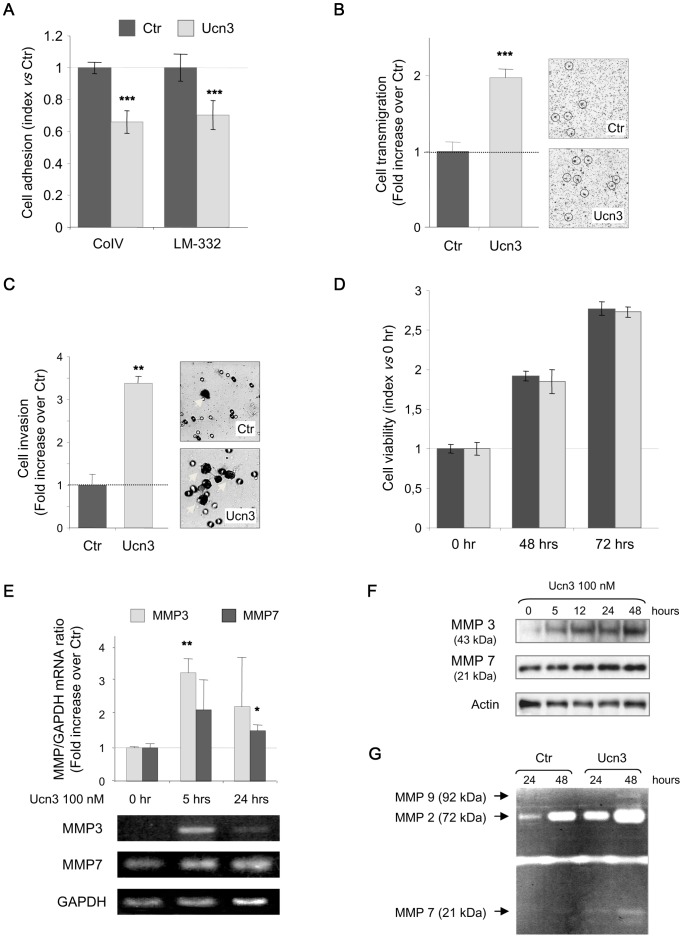
CRF2 signaling alters cell adhesion in favor to cell migration and invasion.(A) HT-29 were treated or not with Ucn3 (100 nM) 30 min before adhesion and then plated on either COIV or LN-332. Cell-ECM adhesion was evaluated at 60 min with the use of a Cell Titer Aqueous MTT reagent kit. Values are normalized to the adhesion without Ucn3. Data represent the mean +/− SEN of 4 separate experiments. Effect of Ucn3 on HT-29 cells transmigration after 72 hrs was determined using a transwell assay (B) and on HT-29 cell invasion after 48 hrs by a matrigel assay (C). In both assays cells were visualized by phase contrast microscopy and counted. A phase contrast image has been joined. A circle has indicated some migrating cells and some invaded cells have been indicated by a white arrow. Data (n>3) are given as mean +/− SEM. (D) Effects of Ucn3 on HT-29 cell viability. (E) Regulation of MMP3 and MMP7 mRNA expression analyzed by RT-PCR in HT-29 cells treated with Ucn3 100 nM. (F) Immunoblot analysis of MMP3 and MMP7 protein expression in HT-29 cells following the time course of Ucn3 treatment. (G) Zymogram of gelatinolytic activities in supernatant of HT-29 cells treated or not with Ucn3 (100 nM) during 24 and 48 hrs.